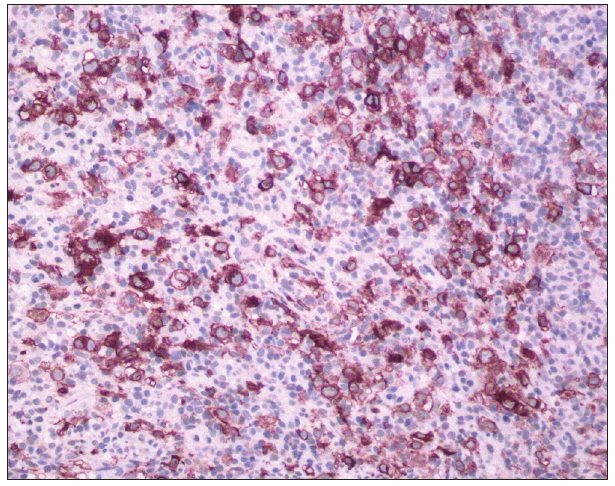
Figure 2) Biopsy of colonic stricture. The large malignant cells